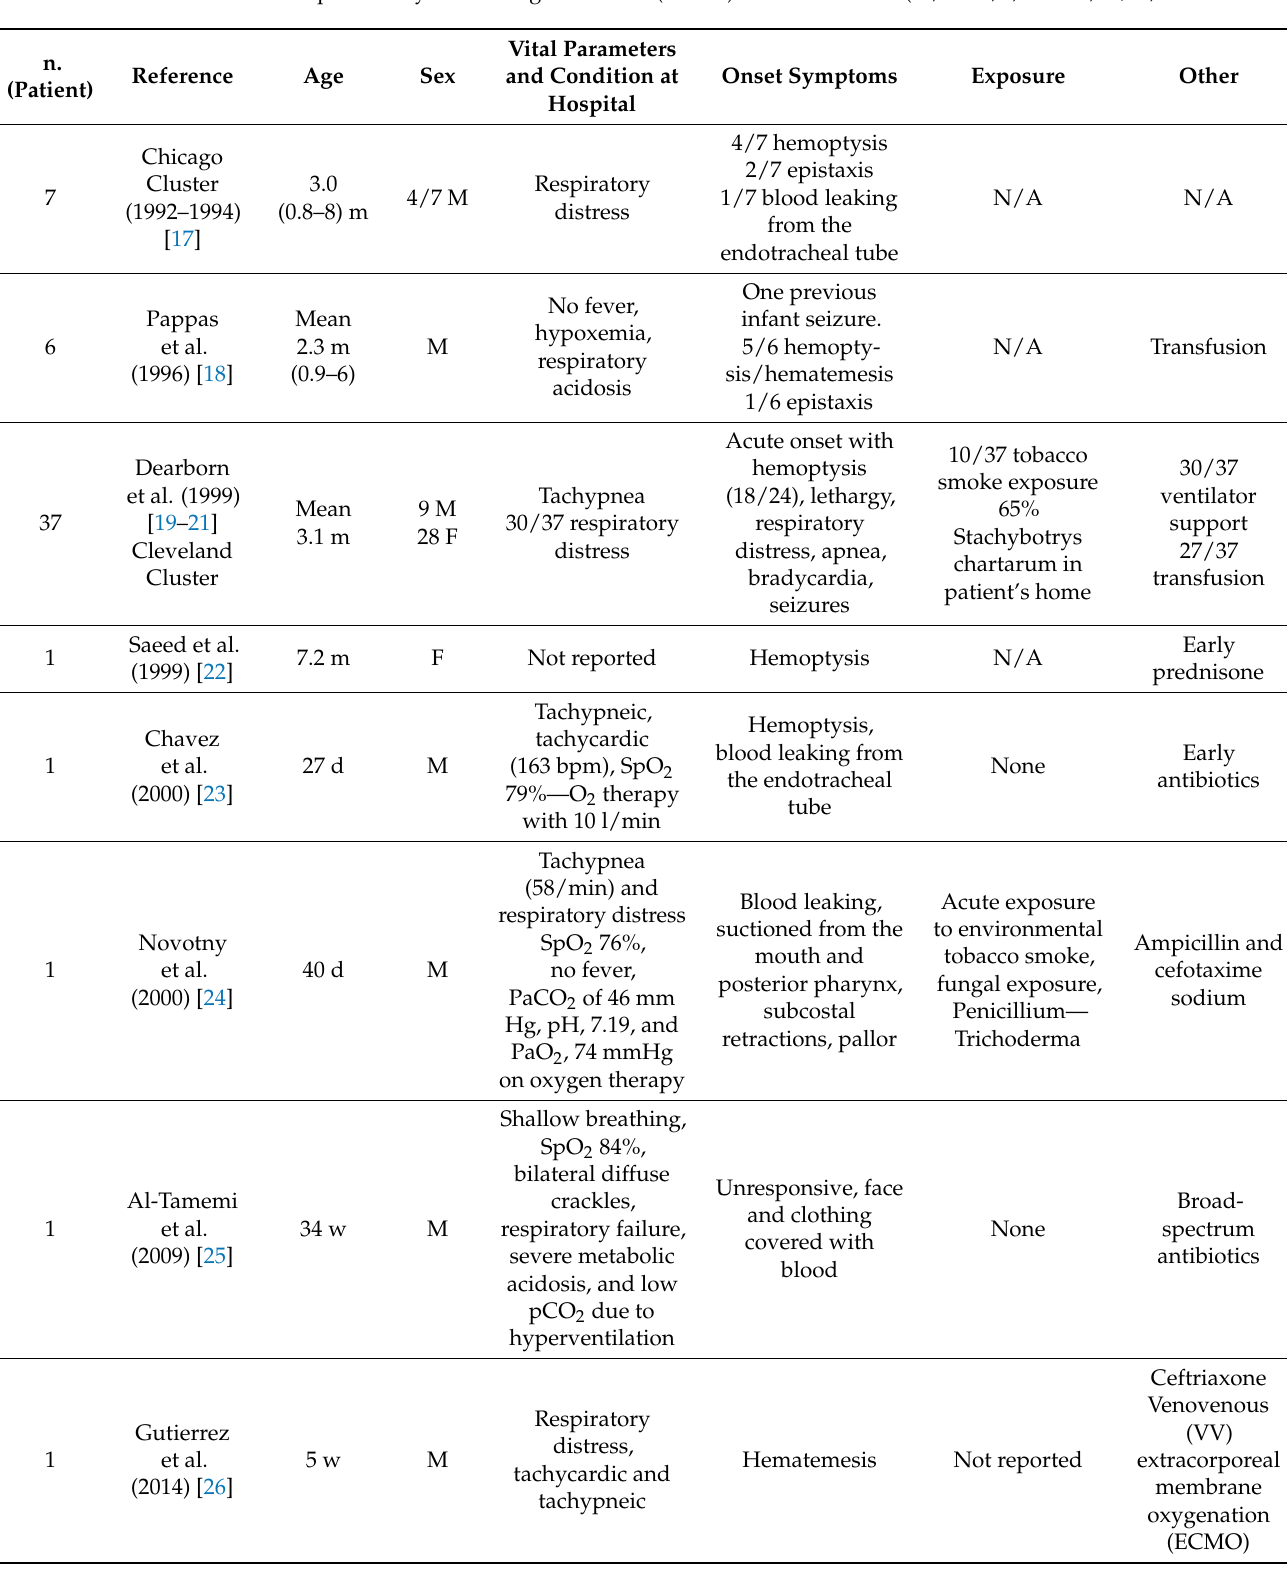
Table 1. The table shows a summary of the findings of all reported clinical cases of acute idiopathic pulmonary hemorrhage in infants (AIPHI) in the literature. (M, male; F, female; N/A, not available).